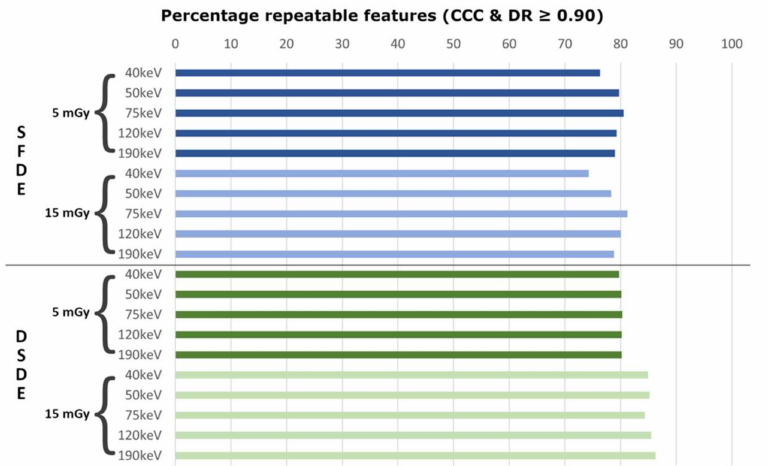
Figure 3. Test–retest repeatability of radiomic features. Bar plots demonstrate the percentage of repeatable features (concordance correlation coefficient (CCC) ≥ 0.9 and dynamic range (DR) ≥ 0.9) for individual VMI energies (40 to 190 keV), DECT approaches (SFDE = split-filter dual-energy, DSDE = dual-source dual-energy), and radiation doses (5, 15 mGy). Overall, DSDE demonstrated higher repeatability at higher radiation dose (light green) and less variability among VMI energies compared to SFDE